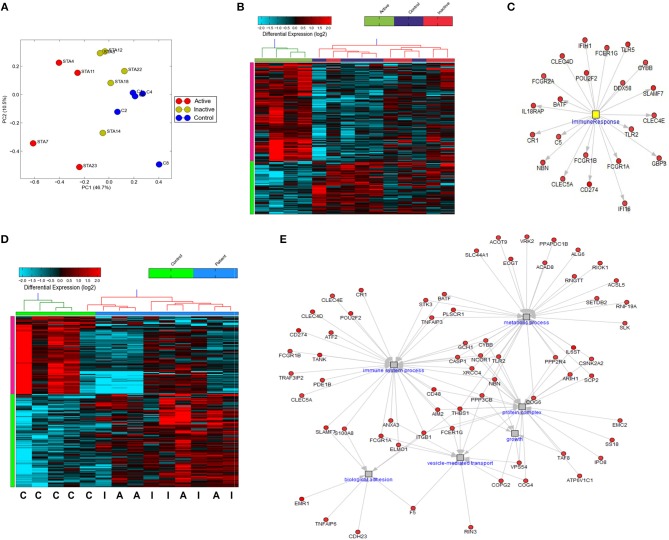
Gene expression profiling of highly purified neutrophils from patients with SJIA. (A) Principle component analysis of differentially expressed genes (DEG) between active SJIA and control neutrophils. (B) Hierarchical clustering of DEGs between active SJIA and control neutrophils (fold change >2.0, p < 0.05). (C) Network analysis of immune response transcription factor cluster genes upregulated in active SJIA neutrophils. (D) Hierarchical clustering of DEGs between all SJIA patients and control neutrophils (fold change >2.0, p < 0.05). (E) Network analysis of genes in significantly enriched GO pathways upregulated in all SJIA patients.